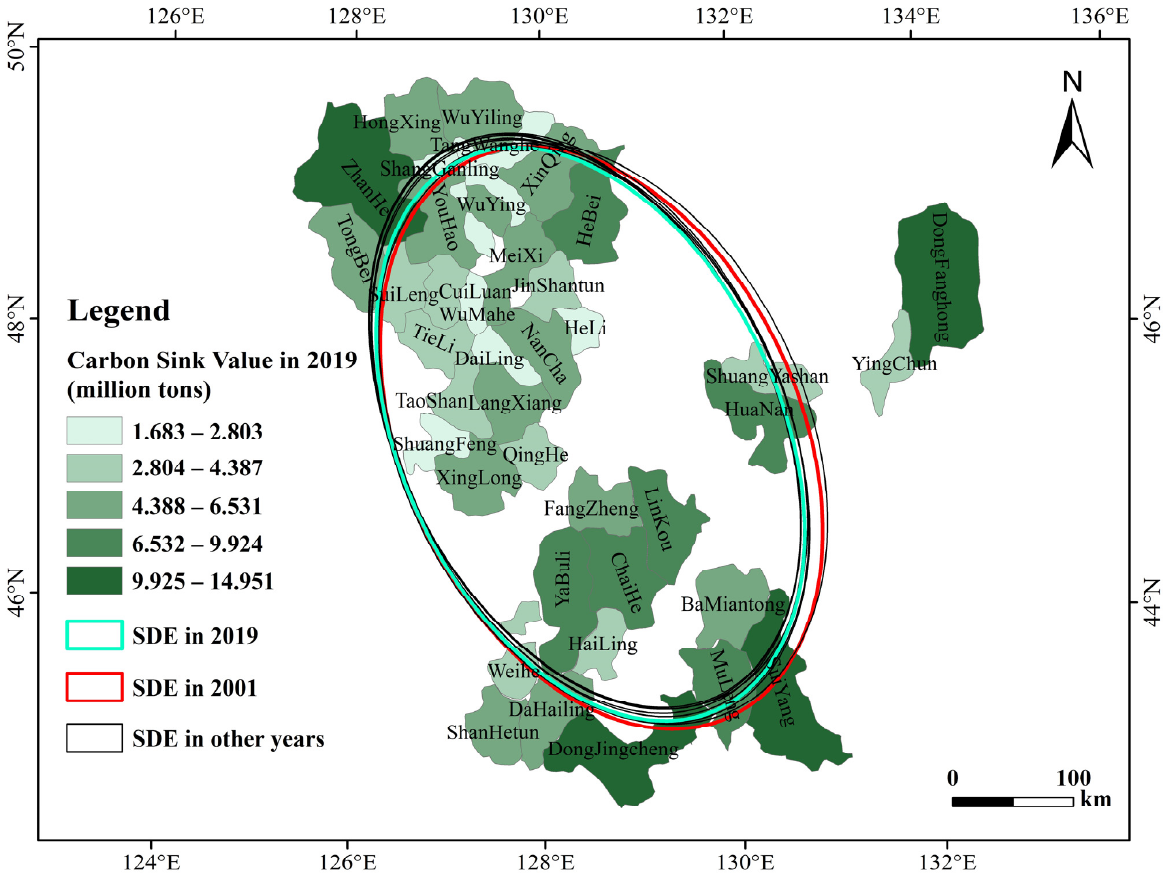
Figure 3. Spatial distribution of the carbon sink and SDE analysis.